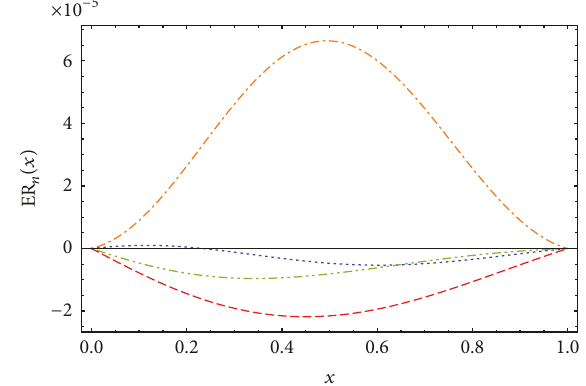
Figure7:ER 𝑛 (𝑥) when 𝑛 = 15 obtainedbytheDuan-Rachmodified ADM for 𝛼 = 1.2 (dot-dash), 𝛼 = 1.4 (dot line), 𝛼 = 1.6 (dot-dot- dash), 𝛼 = 1.8 (dash line), and 𝛼 = 2 (solid line).